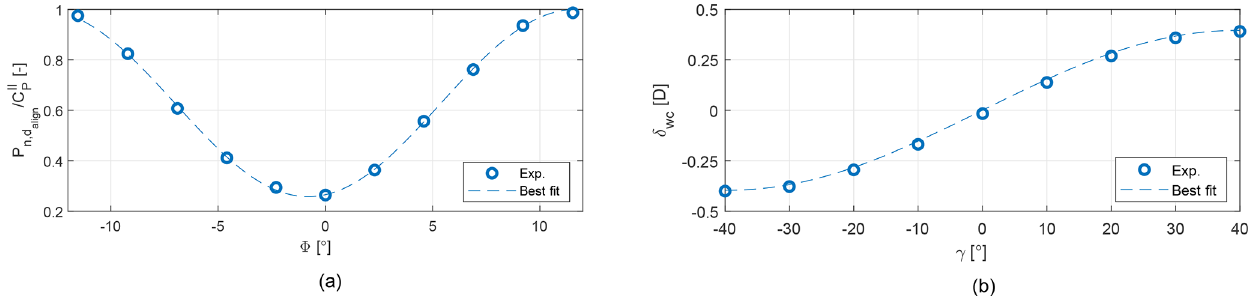
Figure A1. Experimental data points and their best fits for the derivation of the interpolating functions. (a) Normalized power of the downstream turbine in a two-turbine cluster vs. (cid:56) for γ u = γ d = 0. (b) Wake displacement vs. misalignment γ